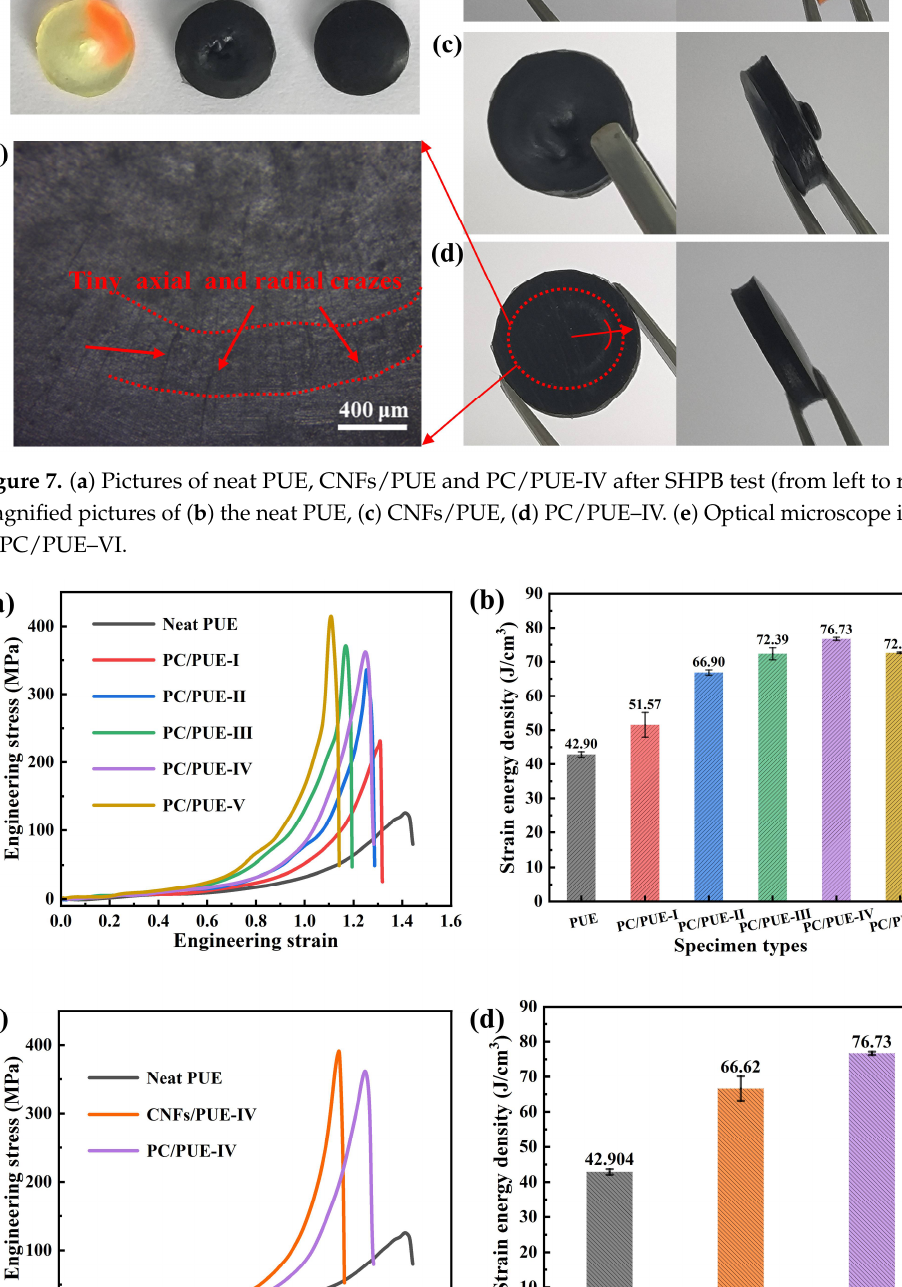
Figure 8. ( a ) Stress–strain curve of PUE composites in SHPB test. ( b ) Strain energy density value of dynamic impact tests of PUE composites, ( c ) Dynamic impact test stress–strain curve of PUE, 1.0% wt.% CNFs/PUE and PC/PUE– Ⅳ , ( d ) Strain energy density value of dynamic impact tests of neat PUE, CNFs/PUE and PC/PUE– Ⅳ .